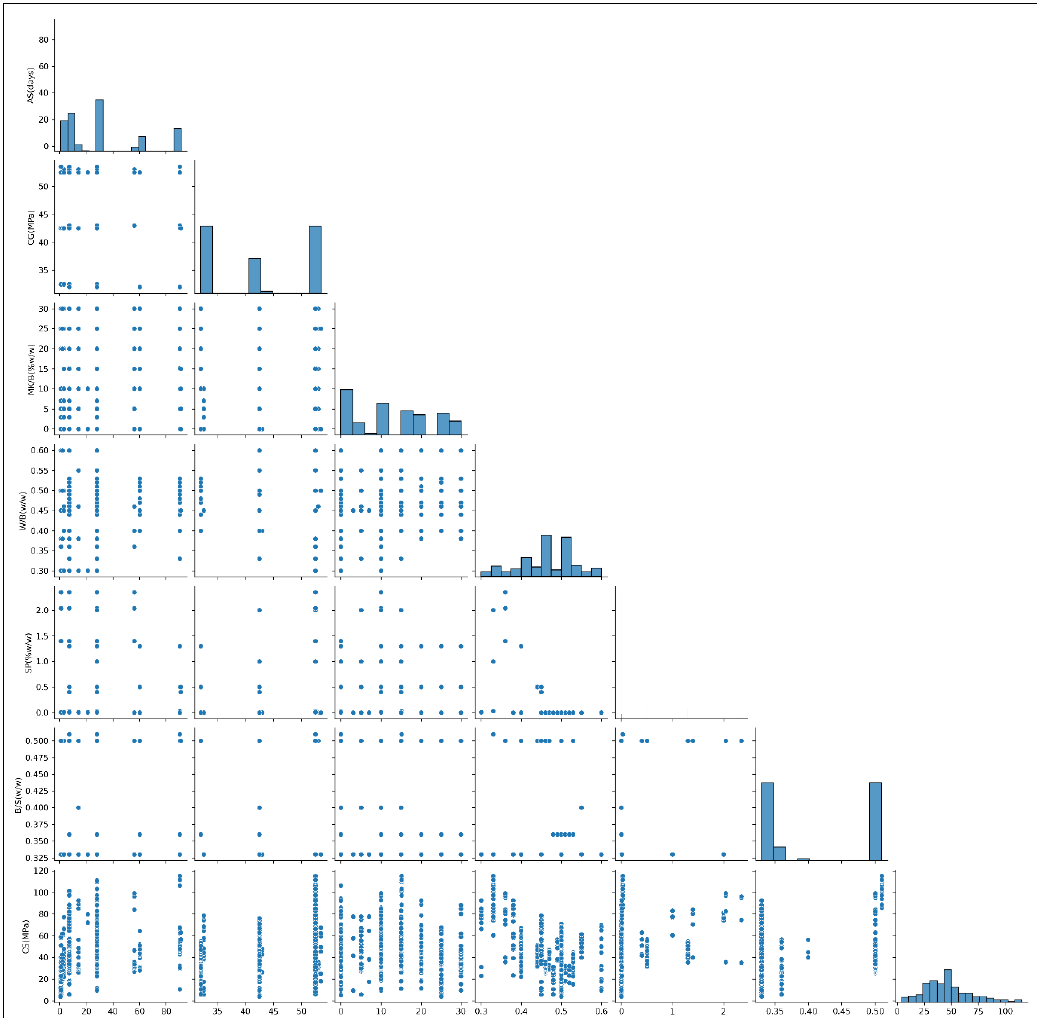
Figure 1. Pair plots for the input parameters and observed responses.